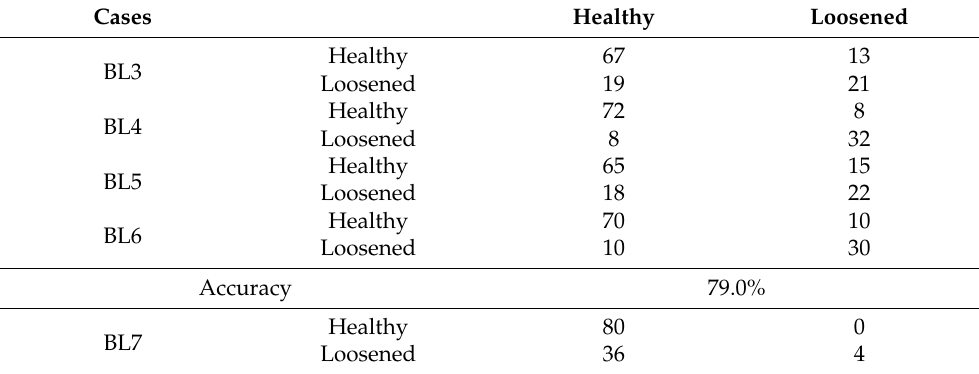
Table 5. Classification results show the average testing accuracy for experimental